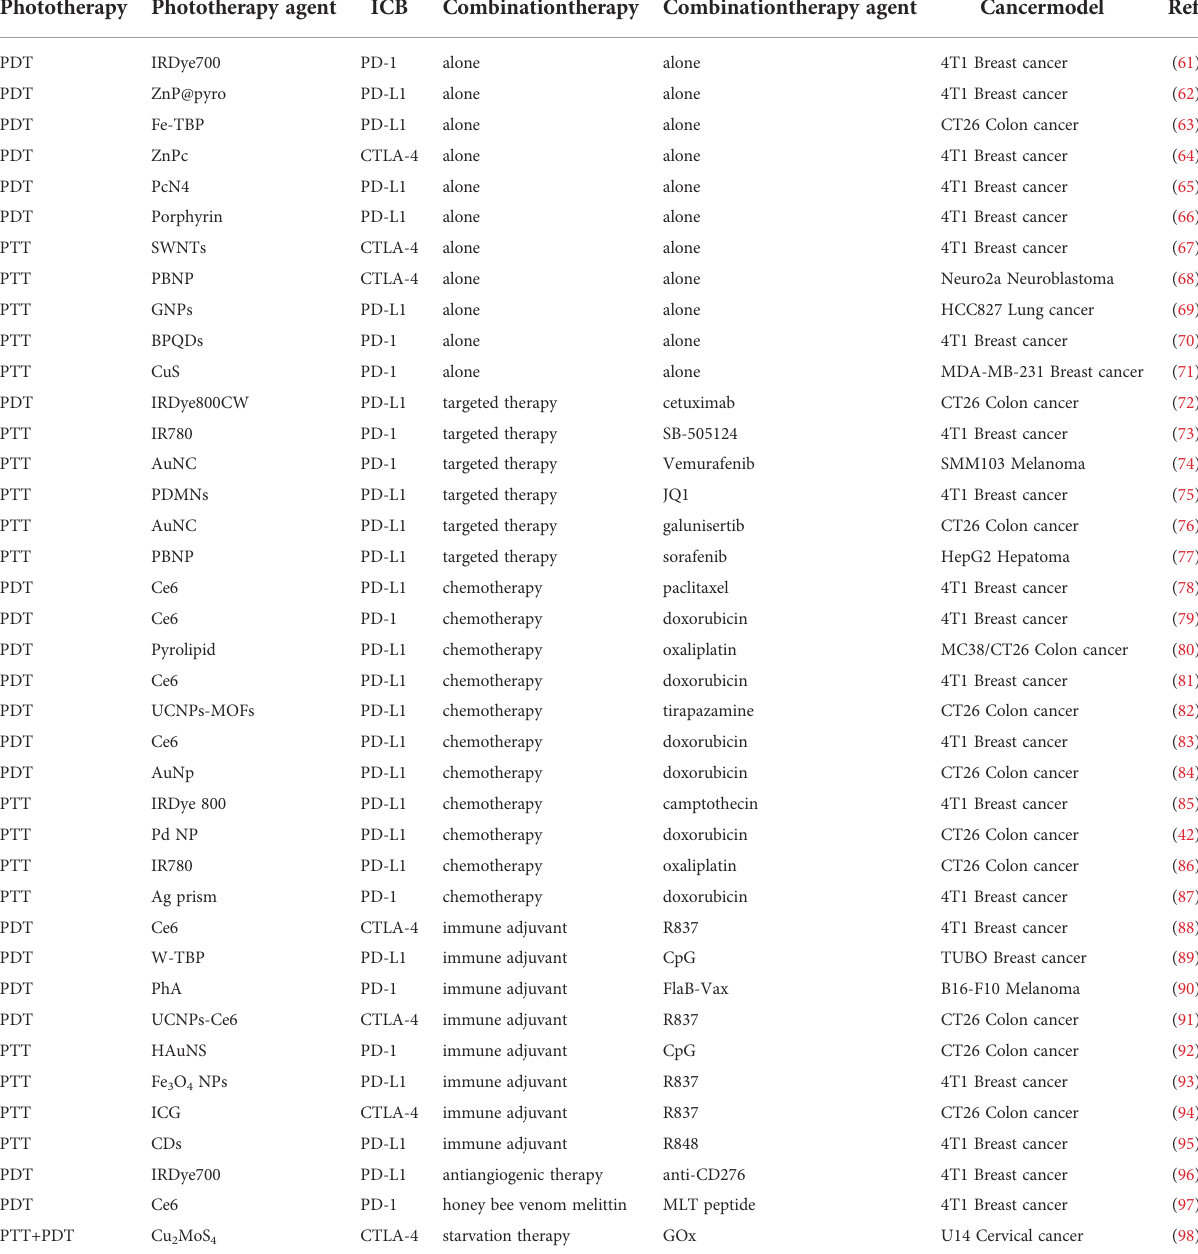
TABLE 1 Preclinical studies of phototherapy-ICB combined therapy or plus other therapeutics. Phototherapy Phototherapy agent ICB Combinationtherapy Combinationtherapy agent Cancermodel